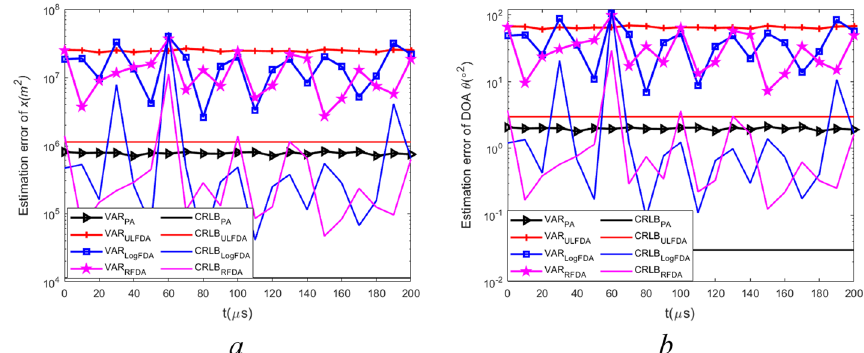
Fig. 11 Estimation error with t . a DOA estimation and b Location